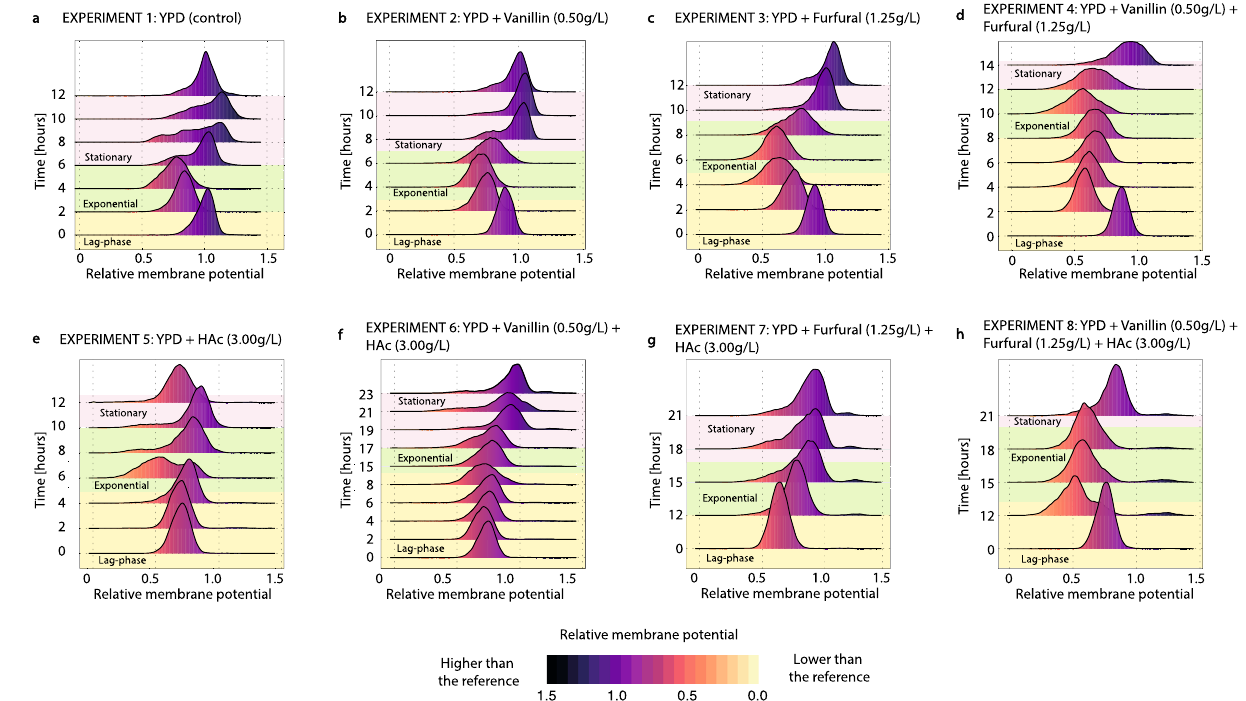
Figure 5. Evolution of the membrane potential of the cell culture during the experiments 1–8. The membrane potential (measured using DiOC 6 (3)) is scaled by the mean of the membrane potential in experiment 1 at time 0 h ( a ). The colour code indicates how far a population is from the reference point (i.e. orange and yellow indicate a membrane potential lower than that of the reference population, while black and dark purple indicate a higher membrane potential than in the reference population). This figure was produced using R 71 . ( a ) YPD control, ( b ) addition of vanillin (0.5 g/L), ( c ) addition of furfural (1.25 g/L), ( d ) addition of vanillin (0.5 g/L) and furfural (1.25 g/L), ( e ) addition of acetic acid (3 g/L), ( f ) addition of vanillin (0.5 g/L) and acetic acid (3 g/L), ( g ) addition of furfural (1.25 g/L) and acetic acid (3 g/L), ( h ) addition of vanillin (0.5 g/L) furfural (1.25 g/L) and acetic acid (3